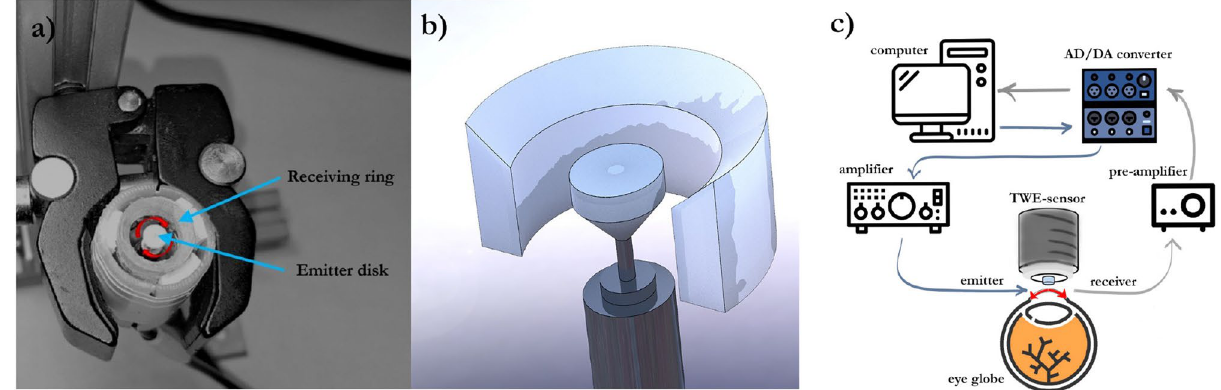
Figure 3. Torsional Wave Elastography (TWE): ( a ) the final assembly with the contact components marked and the attenuator elements visible in white on the contour of the device; ( b ) rendered isometric view where the curvature of the contact ring is visible; ( c ) experimental setup for corneal tissue characterization using